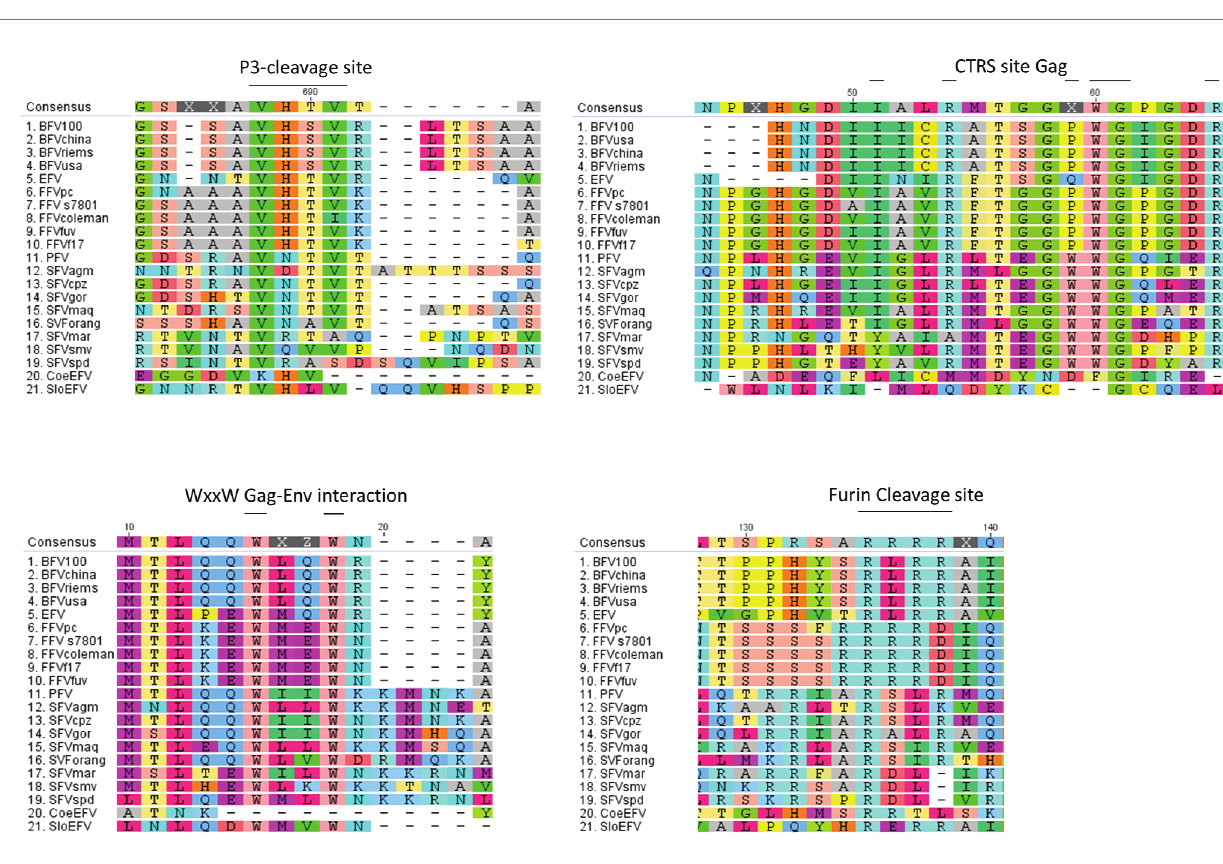
Figure 5. Identification of molecular features thought to be FV-specific in distinct FV species: all FVs sequences used are listed in Table 2. Here, alignments of Gag and Env amino acid sequences (in single-letter code) are shown displaying the p3 cleavage site and CTRS motif in Gag as well as the WxxWmotif in Elp and the furin cleavage site in Env. The consensus amino acid sequence is listed at the top of each set with colored capital letters. Dashes indicate amino acids missing in the isolates. The putative motifs mentioned above are indicated by bold lines over the consensus sequence. Viral abbreviations are given in Table 2. The alignment was performed with a global alignment method with